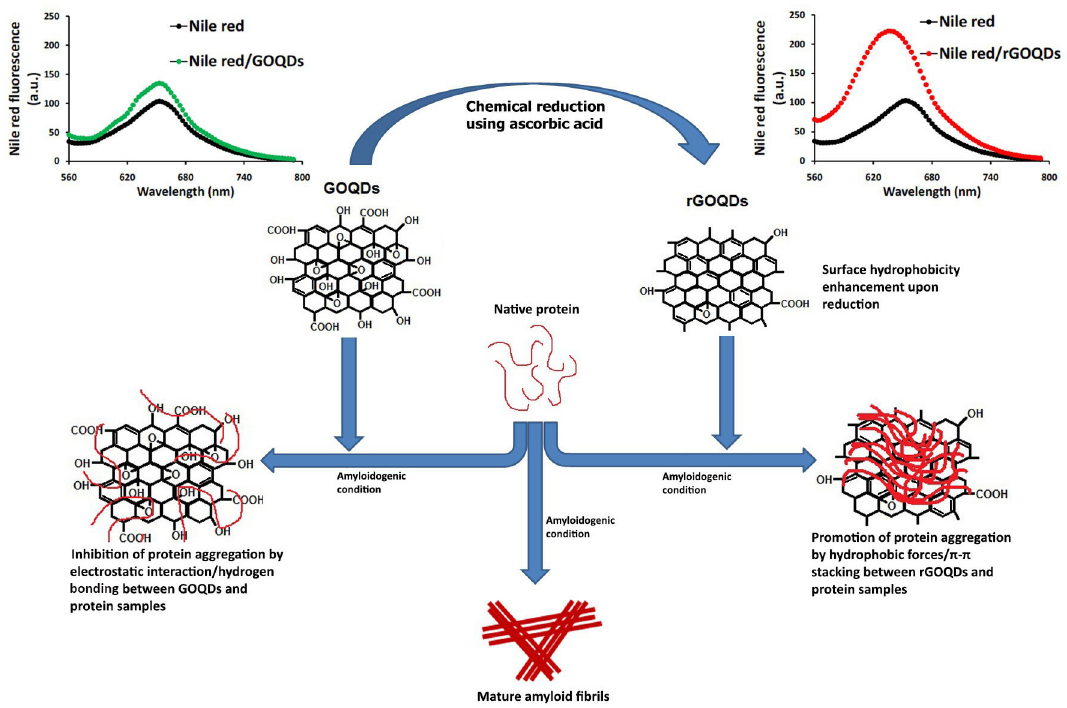
Fig 10. Schematic presentation of possible mechanism of GOQDs/rGOQDs action on modulating amyloid fibril formation.